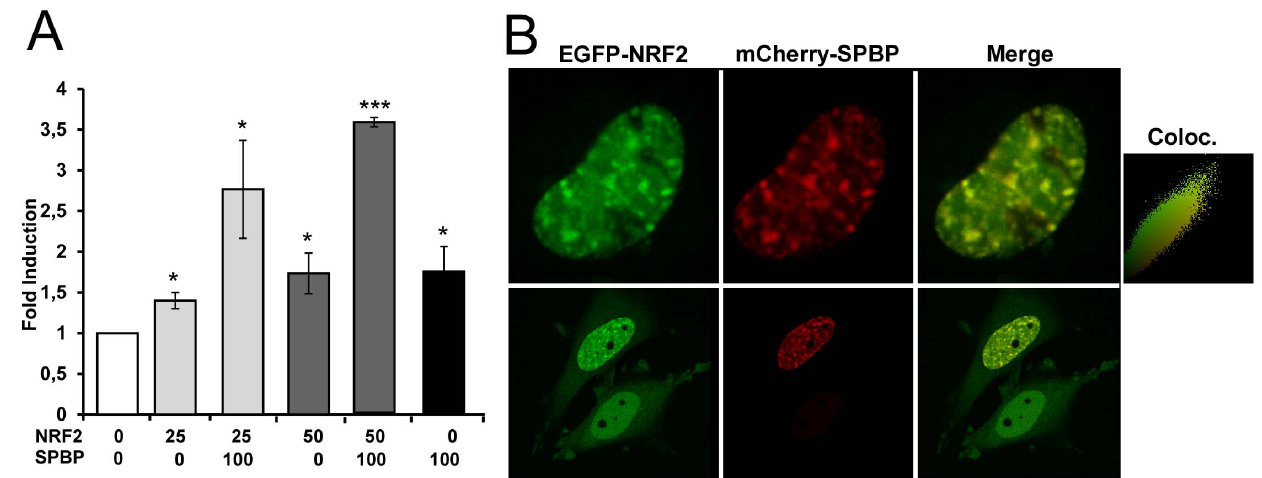
Figure 6. SPBP and NRF2 cooperate to induce expression from the p62 promoter, and colocalize in nuclear speckles. ( A ) SPBP and NRF2 cooperate to enhance expression from the wild type p62 promoter. Transient transfections were carried out in HEK293 cells using 60 ng of the p62 promoter construct ( 2 1781/ + 46), and 50 ng or 100 ng of an NRF2 expression vector, and 100 ng of a SPBP expression vector, as indicated. The data represent the mean of three independent experiments with standard deviations, each performed in triplicate (***p , 0.001, *p , 0.05). ( B ) SPBP recruits NRF2 to specific nuclear speckles. HeLa cells were transiently transfected with expression vectors for EGFP-NRF2 and mCherry-SPBP, and analysed 24 hours post transfection by live cell imaging using a confocal laser scanning fluorescence microscope. The Pearson’s colocalisation scatter was generated using Volocity (Perkin Elmer).